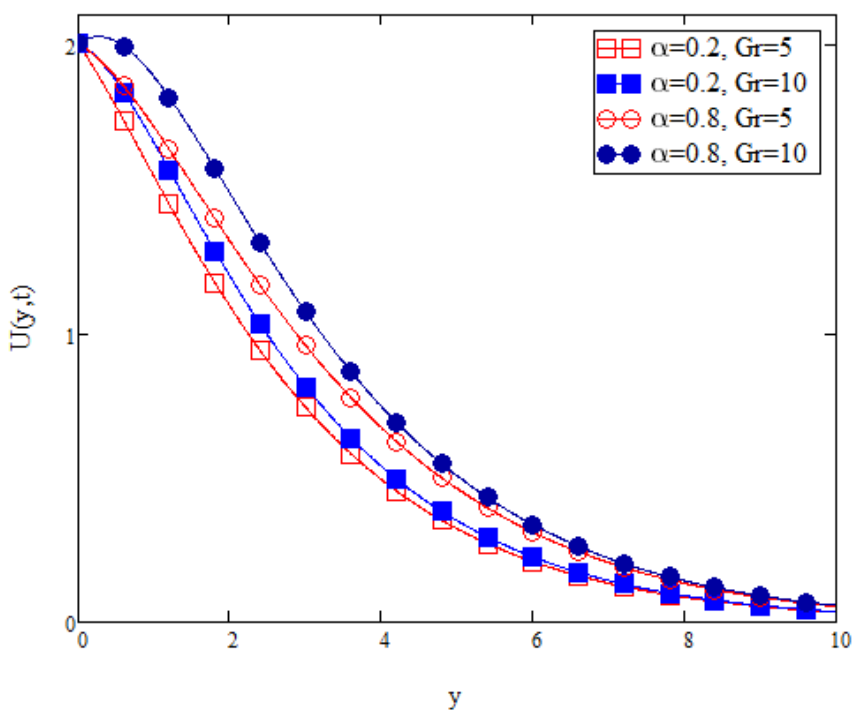
Figure 12. Variation in velocity profile due to variations in Gr and α .